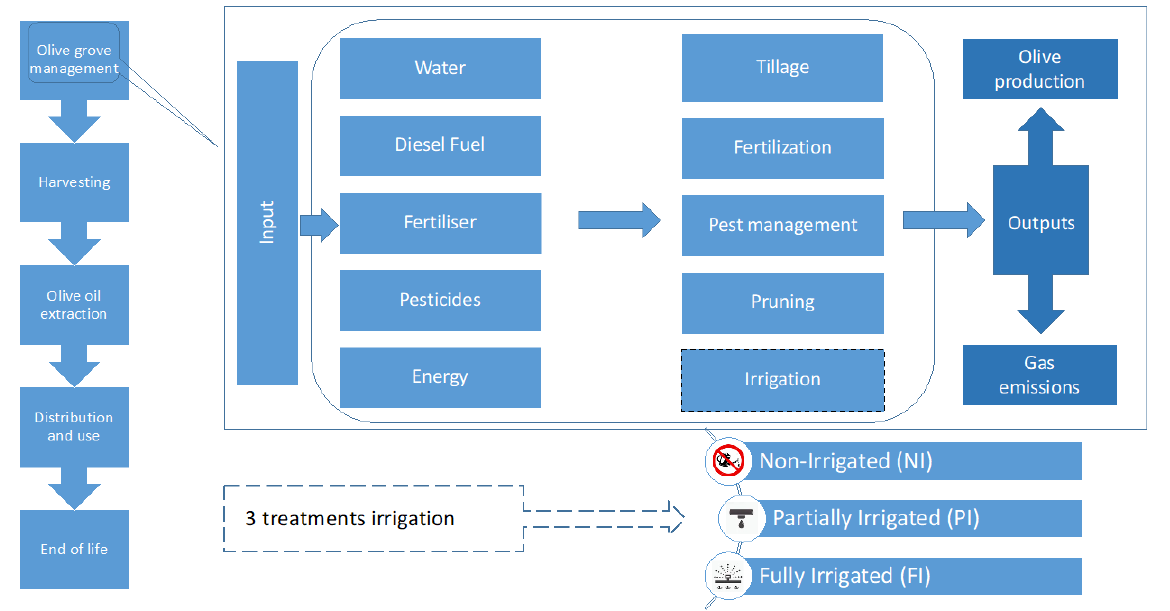
Figure 3. Production system analyses with details of the input per operation.